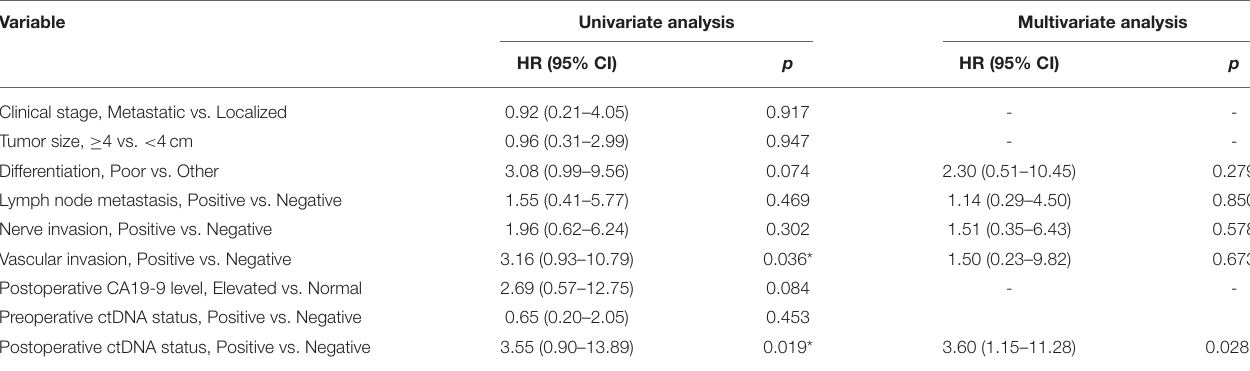
TABLE 2 | Univariate and multivariate cox analysis for risk factors of relapse. Variable